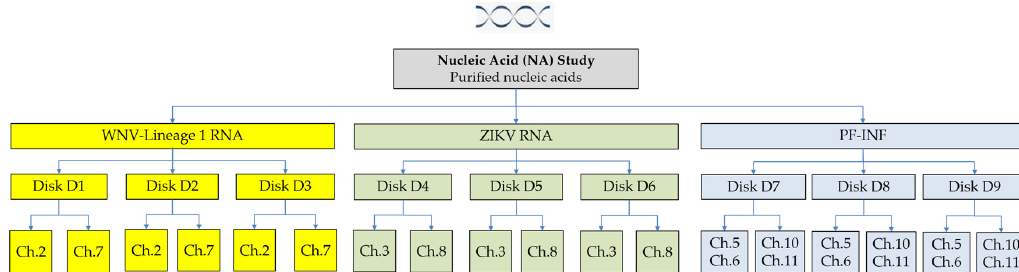
Figure 2. Schematic workflow of testing the three nucleic acid (NA) samples in the VectorDisk during the NA Study. ‘PF-INF’ represents the mixture of P. falciparum DNA + P. falciparum infective stage RNA.